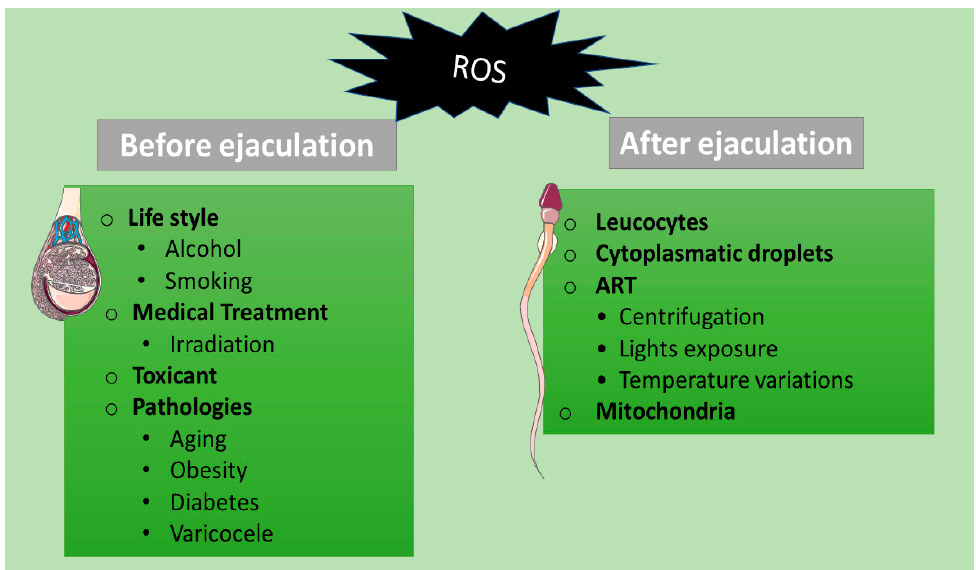
Figure 1. Potential stimuli that cause reactive oxygen species (ROS) production in spermatozoa.